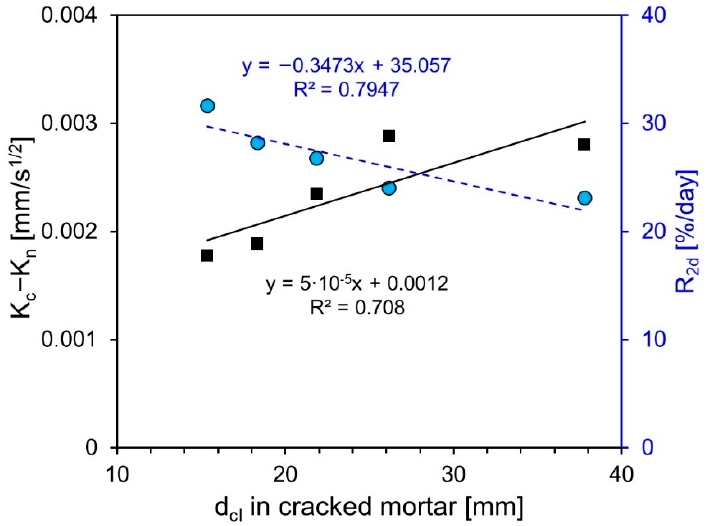
Figure 11. Correlation among self-healing performance of specimens including clinker binder and clinker sand determined by each test method.